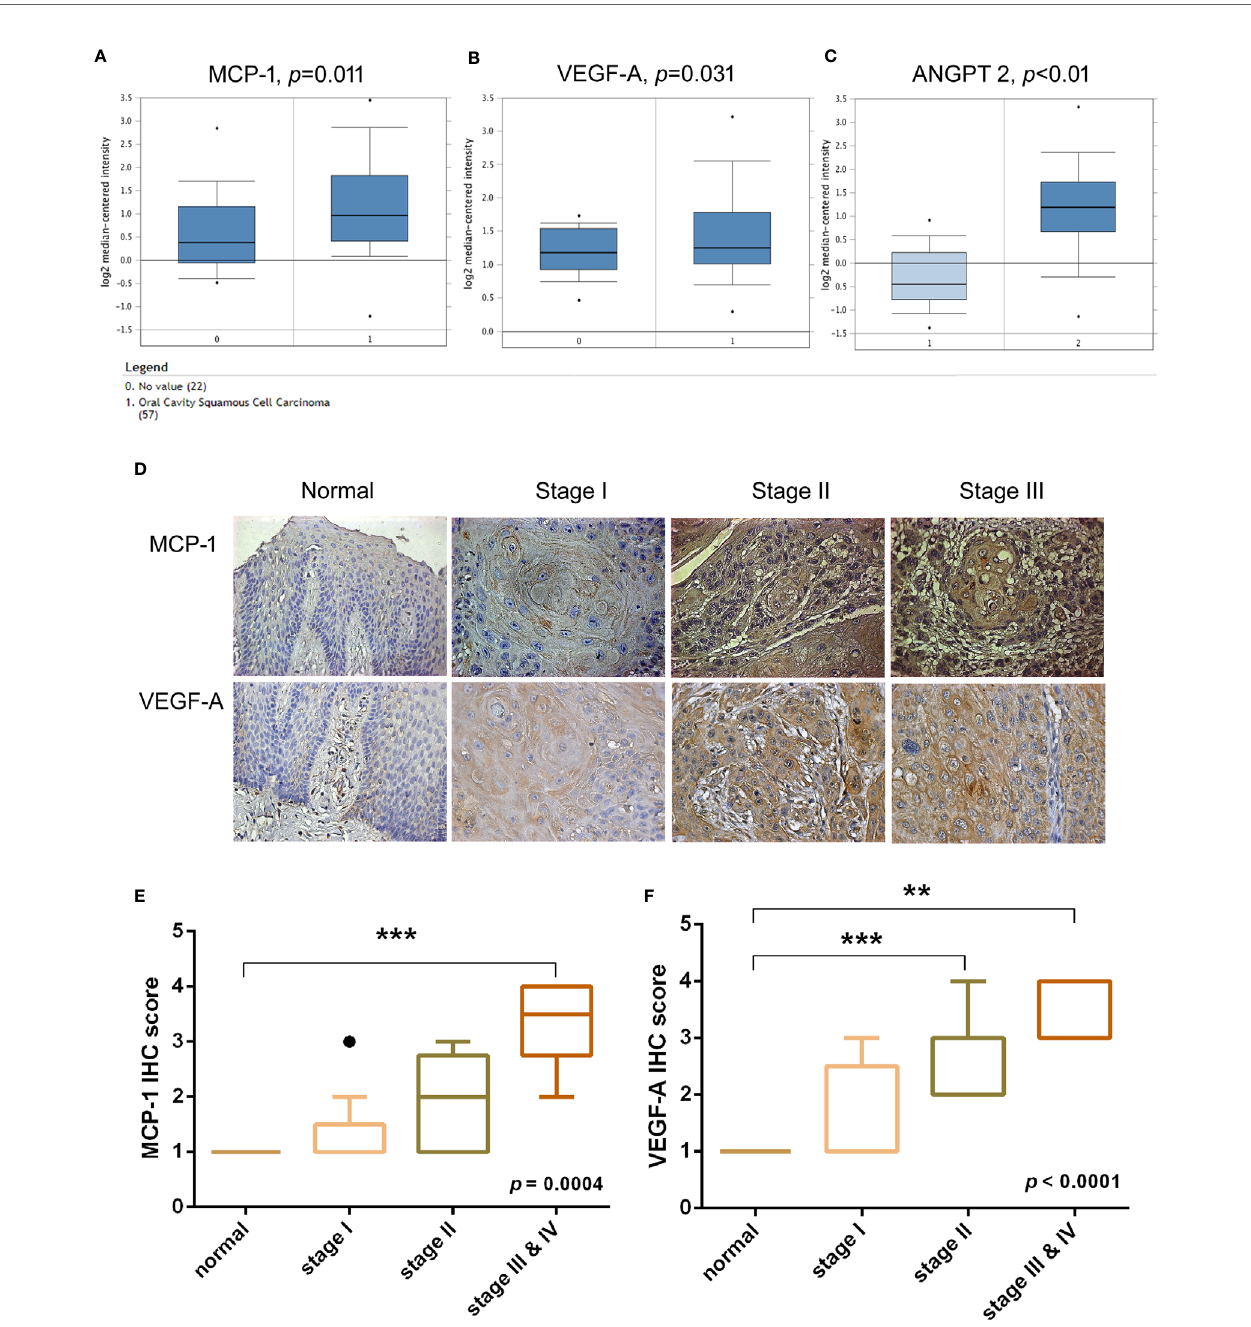
FIGURE 1 | Clinical signi fi cance of MCP-1 in angiogenesis of oral squamous cell carcinoma. (A – C) OSCC tissue and adjacent normal tissue data from the Oncomine database (https://www.oncomine.org) were analyzed for MCP-1, VEGF-A, and ANGPT2 expression. (D) IHC photographs of tissue array sections (OR601) immunostained with anti-MCP-1 or anti-VEGF-A antibody. (E, F) IHC results were scored on a scale of 1 – 5 for staining intensity. Levels of MCP-1 and VEGF-A expression correlated with OSCC clinical grade. **p < 0.005 , ***p < 0.0005 compared with controls. (A – C, E) are box-and-whisker plots that plot outliers as individual points